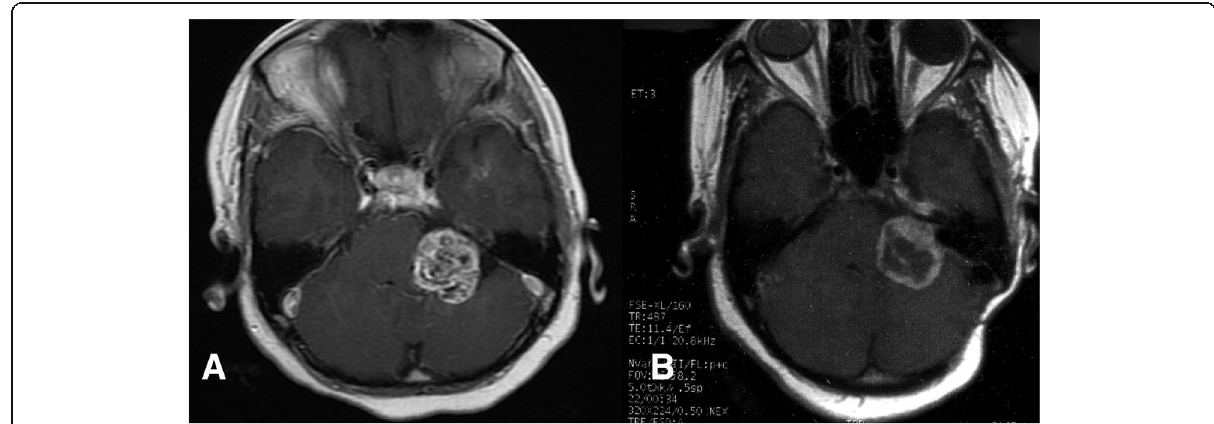
Fig. 5 a Axial T1 postcontrast MRI showing vestibular schwannoma. b An 8-month postoperative axial postcontrast MRI after radiosurgery. HB was grade I. The facial nerve was located posteriorly (Fig. 1b, c)